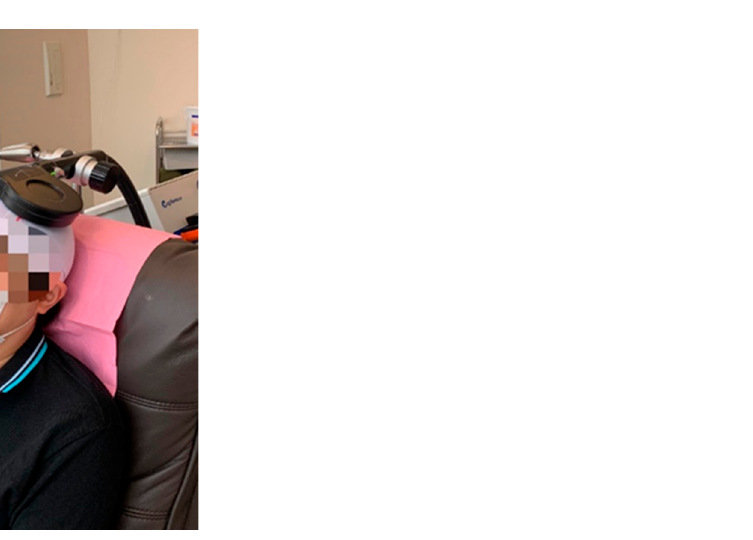
Figure 1. The photo shows the placement of the butterfly coil with the patient’s bilateral dorsal mPFC as the stimulation target in this treatment protocol. as the stimulation target in this treatment